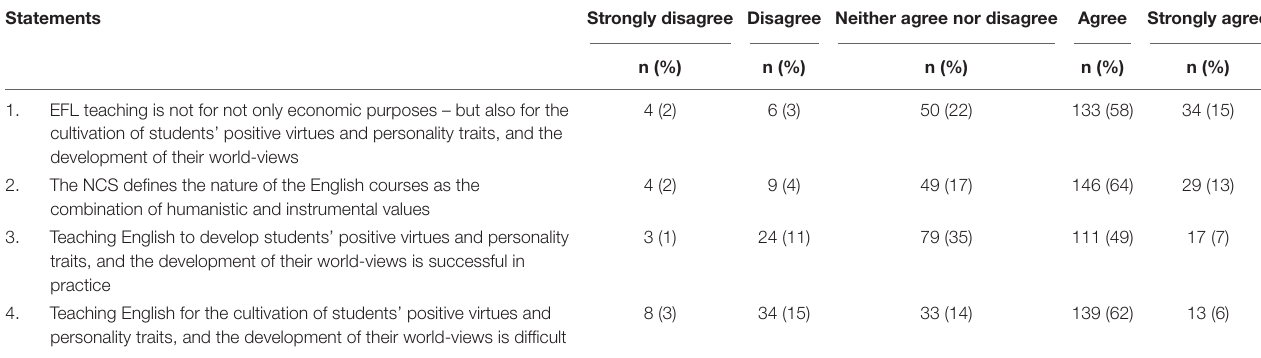
TABLE 1 | Teachers’ responses to statements about humanistic values.